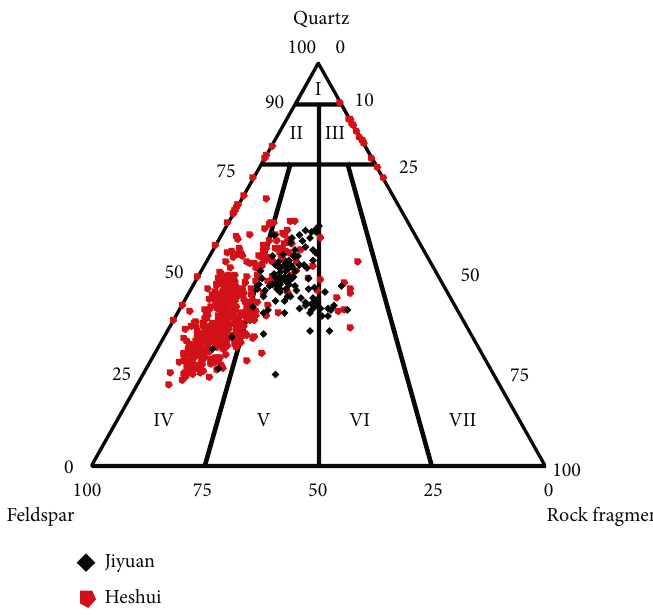
Figure 2: Characteristics and types of sandstones in the research